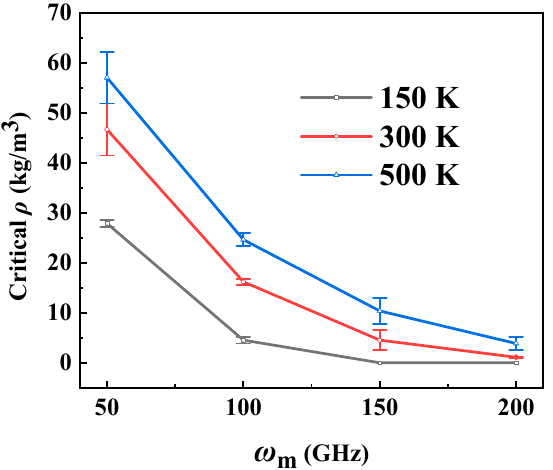
Figure 8. The relationship between the critical working helium density range and ω m at different system temperatures.